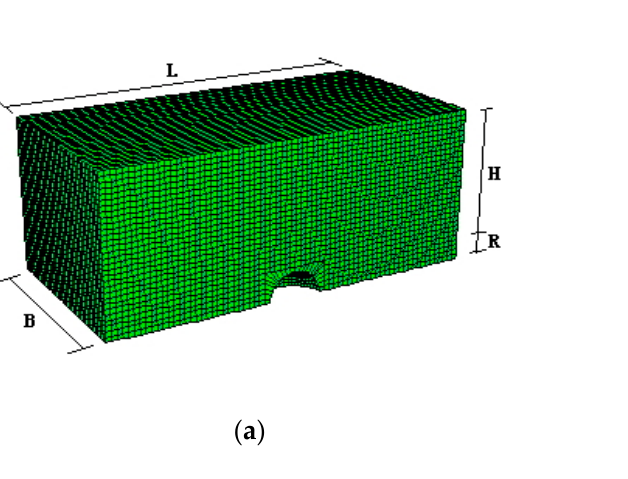
Figure 8. Sketch of numerical simulation model. ( a ) 1/4 geometry model, and mesh; ( b ) The dimensions of numerical simulation model.